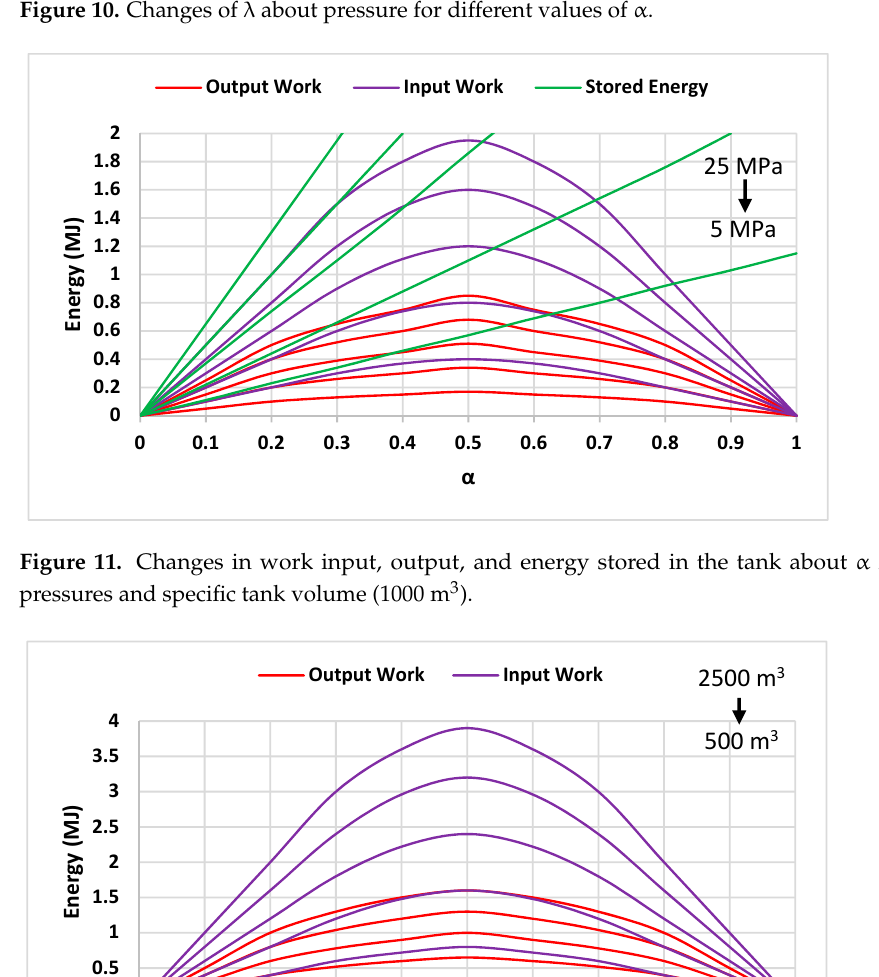
Figure 10. Changes of λ about pressure for different values of α .